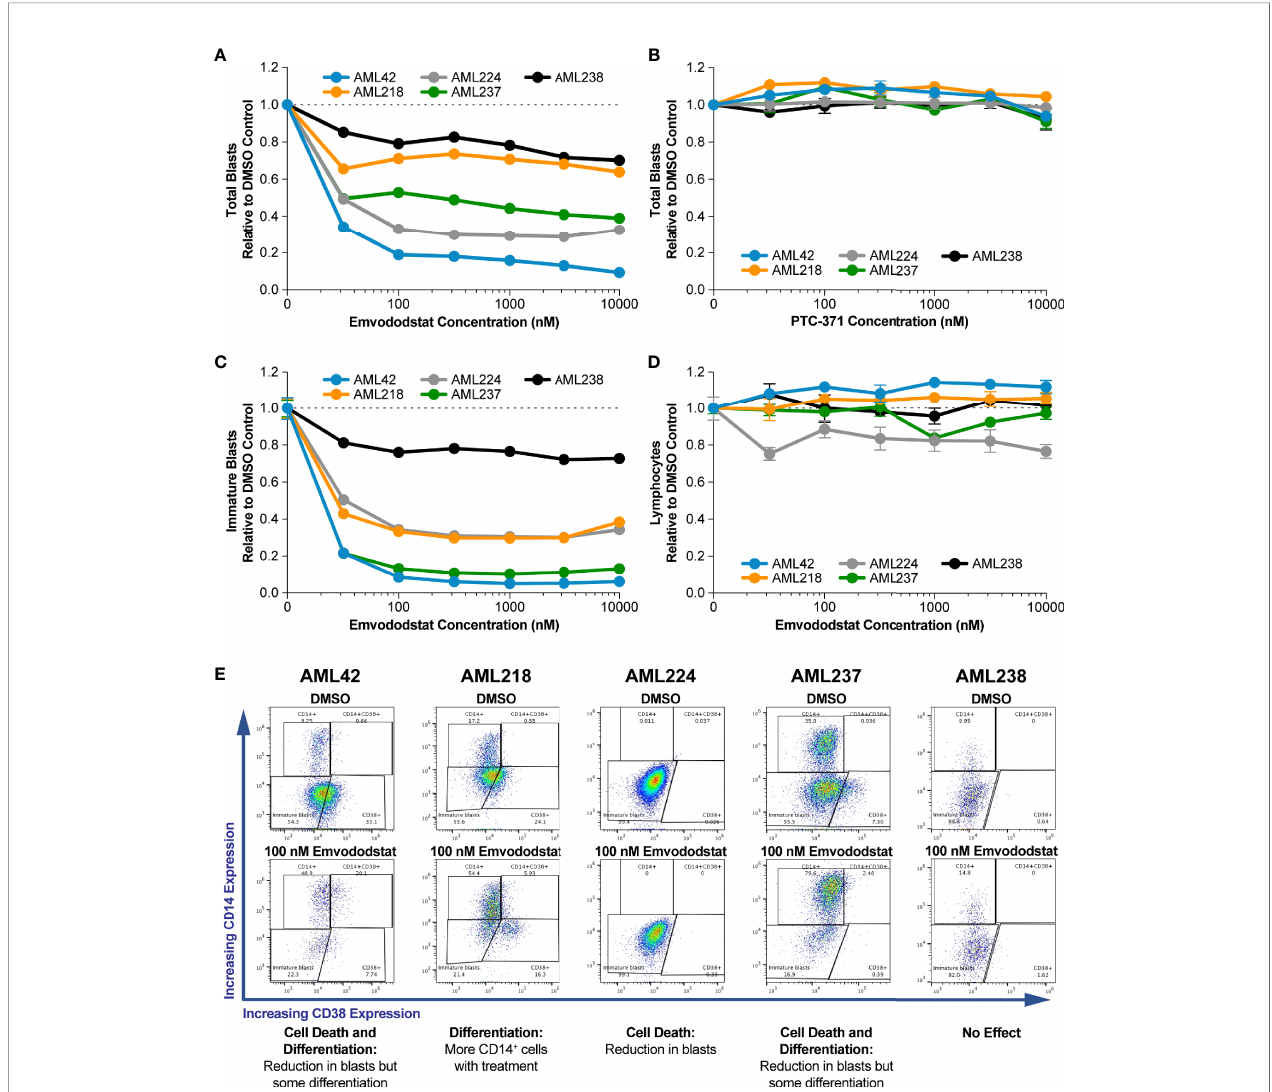
FIGURE 3 | Primary AML blasts cultured ex vivo were treated with increasing concentrations of emvododstat or its inactive enantiomer PTC-371 at 37°C for 72 hours. Samples were then stained with appropriate antibodies and evaluated using a fl ow cytometer. For panels (A-D) , values represent the mean ± SD for triplicate values. Decrease in the fraction relative to control of (A) total blast cells treated with emvodostat, (B) total blast cells treated with PTC-371, (C) immature blast cells treated with emvodostat, or (D) lymphocytes treated with emvodostat. (E) Flow cytometry analysis of primary AML patient samples. Shown are data from blood obtained from 5 AML subjects incubated ex vivo with 100 nM emvodostat or